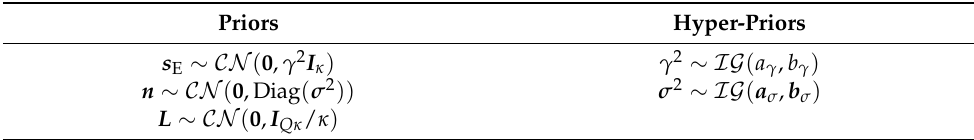
Table 1. Prior PDFs assigned to the unknown variables of